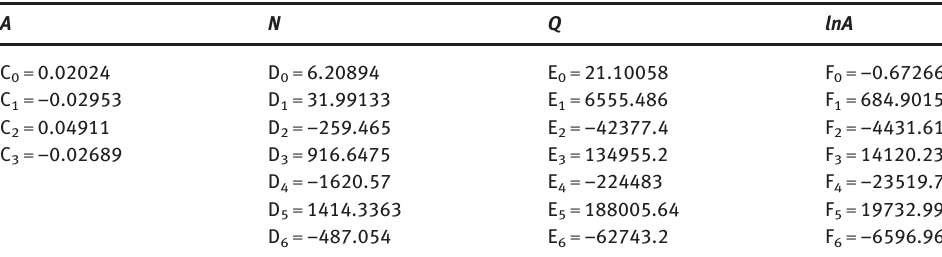
Table 3: Coefficients of the polynomial for α , n, Q , and lnA.